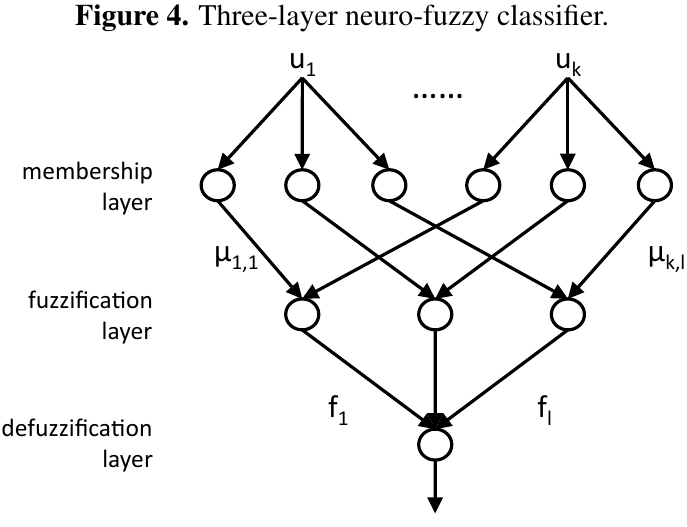
Figure 4. Three-layer neuro-fuzzy